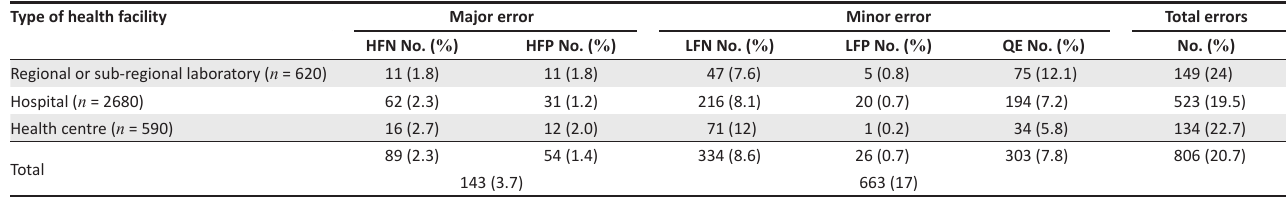
TABLE 5: Type of errors committed by external quality assessment rechecking laboratory microscopists in detecting tuberculosis bacilli by type of institution, Ethiopia ( N =3890 slides), April–July, 2015. Type of health facility Major error Minor error Total